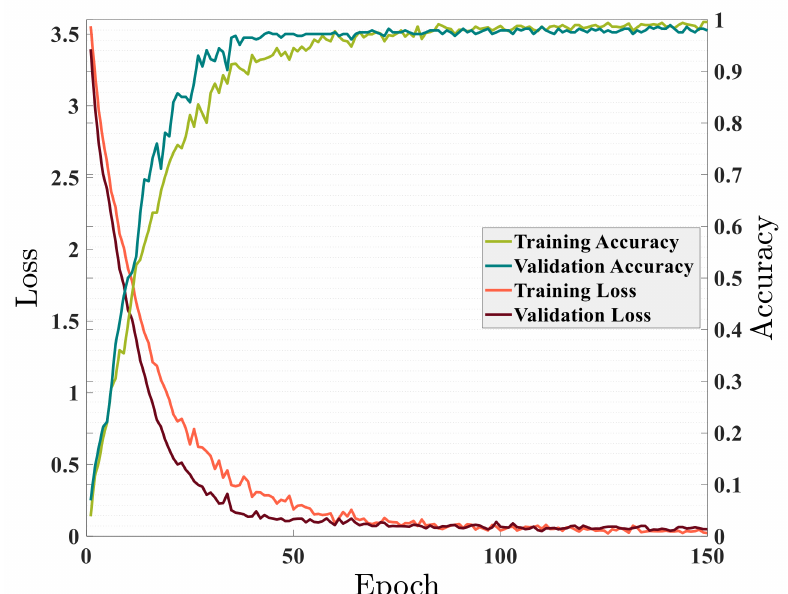
Figure 10. Accuracy and loss on train and validation sets with DGs penetration in the